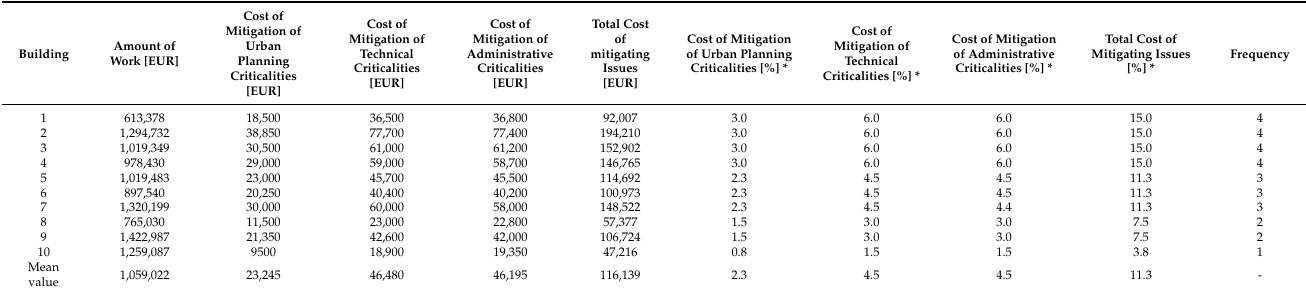
Table 6. Definition of the percentage costs of urban, technical, and administrative criticalities as a percentage of the amount of the works for the 10 projects carried out on multi-family buildings started before the introduction of CILAS.